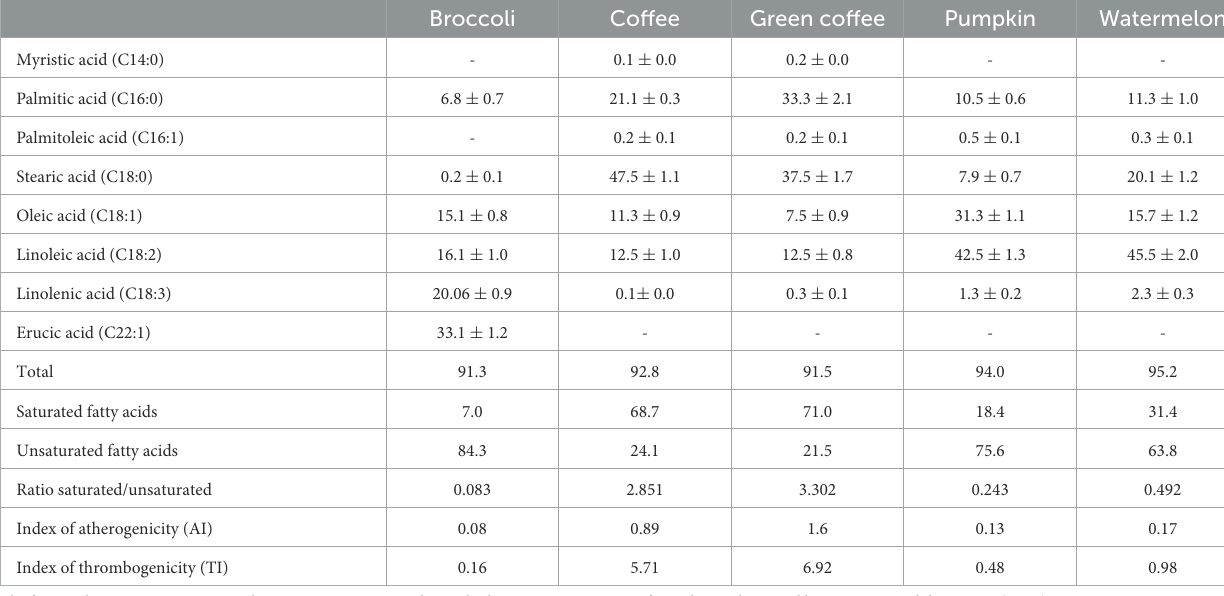
TABLE 1 Fatty acid composition (%), index of atherogenicity (IA) and index of thrombogenicity (IT) of the cold-pressed seed oils of broccoli, coffee, green coffee, pumpkin, and watermelon. Broccoli Coffee Green coffee Pumpkin